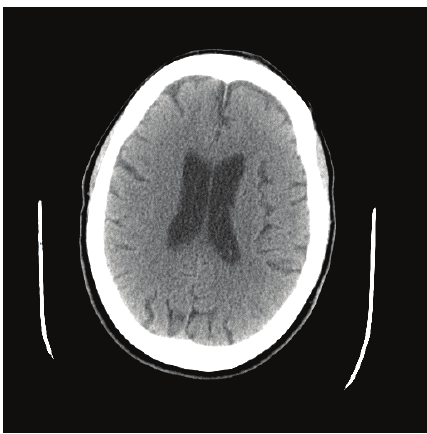
Figure 1: Axial brain computerized tomography exhibiting diffuse cortical atrophy, prominent sulci, and ex vacuo ventricular enlarge-